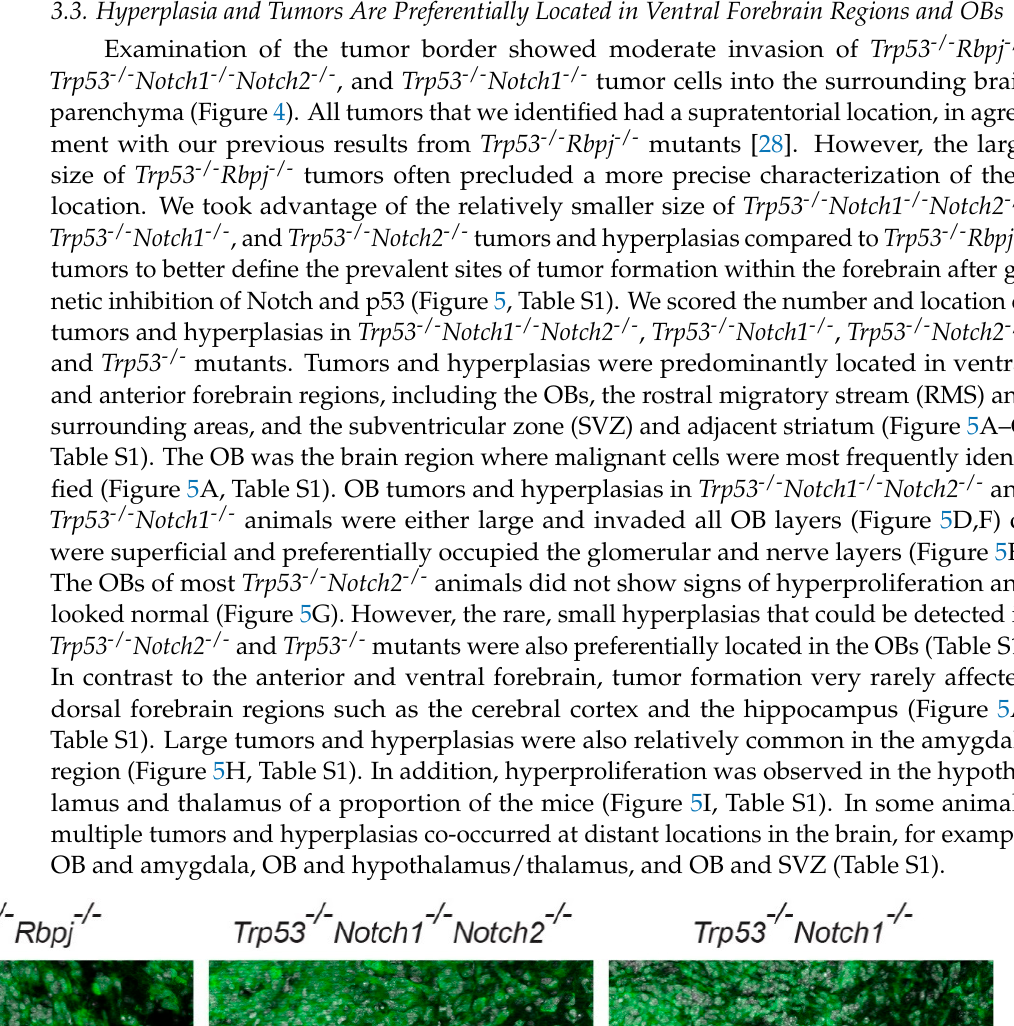
Table 1. PCNA + cells(%ofGFP + cells)inhyperplasiasandtumors. Datarepresentmean ± standarddeviation. Trp53 -/- Trp53 -/- Rbpj -/- Trp53 -/- Notch1 -/- Notch2 -/- Trp53 -/- Notch1 -/- Trp53 -/- Notch2 -/-